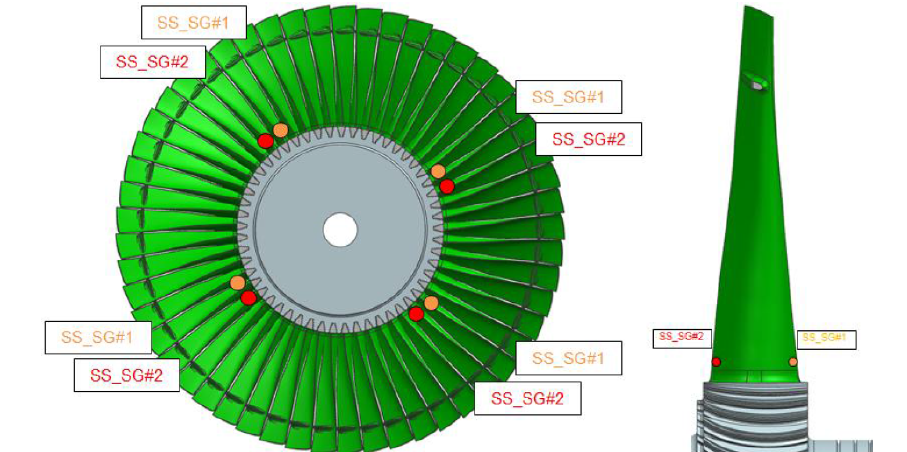
Figure 4. Strain gauges positioning on the last blade row.